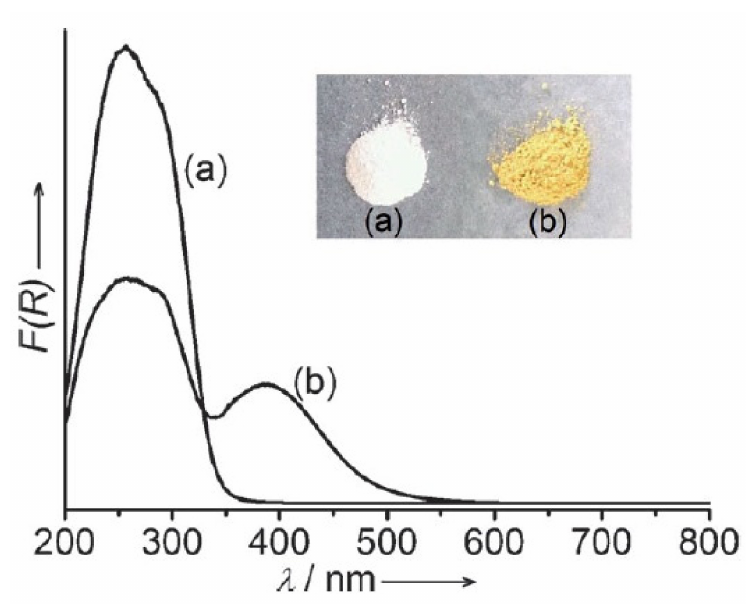
Figure 17. UV/Vis spectra of ( a ) MIL-125 (Ti) and ( b ) NH 2 -MIL-125 (Ti)